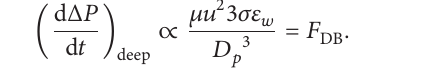
From (1), the values of ( d Δ𝑃/ d 𝑡) initial are directly proportional to the viscosity 𝜇 , 𝑢 2 , 3𝜎 , and 𝜀 𝑤 and inversely proportional to 𝐷 𝑝3 . The values of the parameter 𝐹 DB defined by (1) are calculated using the above parameters, and the relationship between ( d Δ𝑃/ d 𝑡) initial and 𝐹 DB is presented in Figure 8. 𝐹 ( d Δ𝑃/ d 𝑡) initial is found to generally increase with DB , while the points are dispersed along the linear fitting curve with the coefficient of determination 𝑅 2 = 0.7546 . Equation (1) is just a dimensional analysis for the parameter of ( d Δ𝑃/ d 𝑡) initial . The detailed physical process is ignored in this analysis, and the large deviation is obtained by directly using this